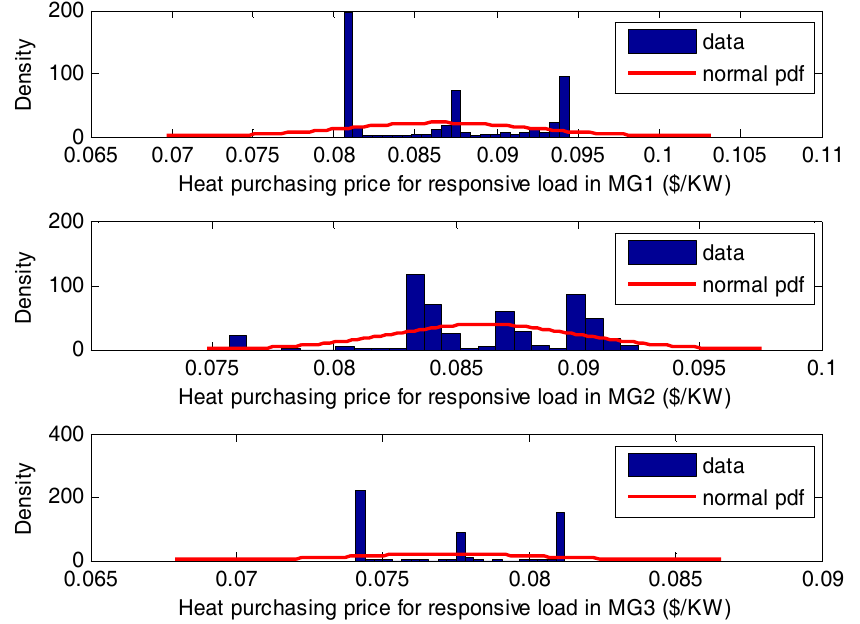
Figure 12. PDF of the final energy price of thermal responsive load. Top: MCMG1; Middle: MCMG2, Bottom: MCMG3.